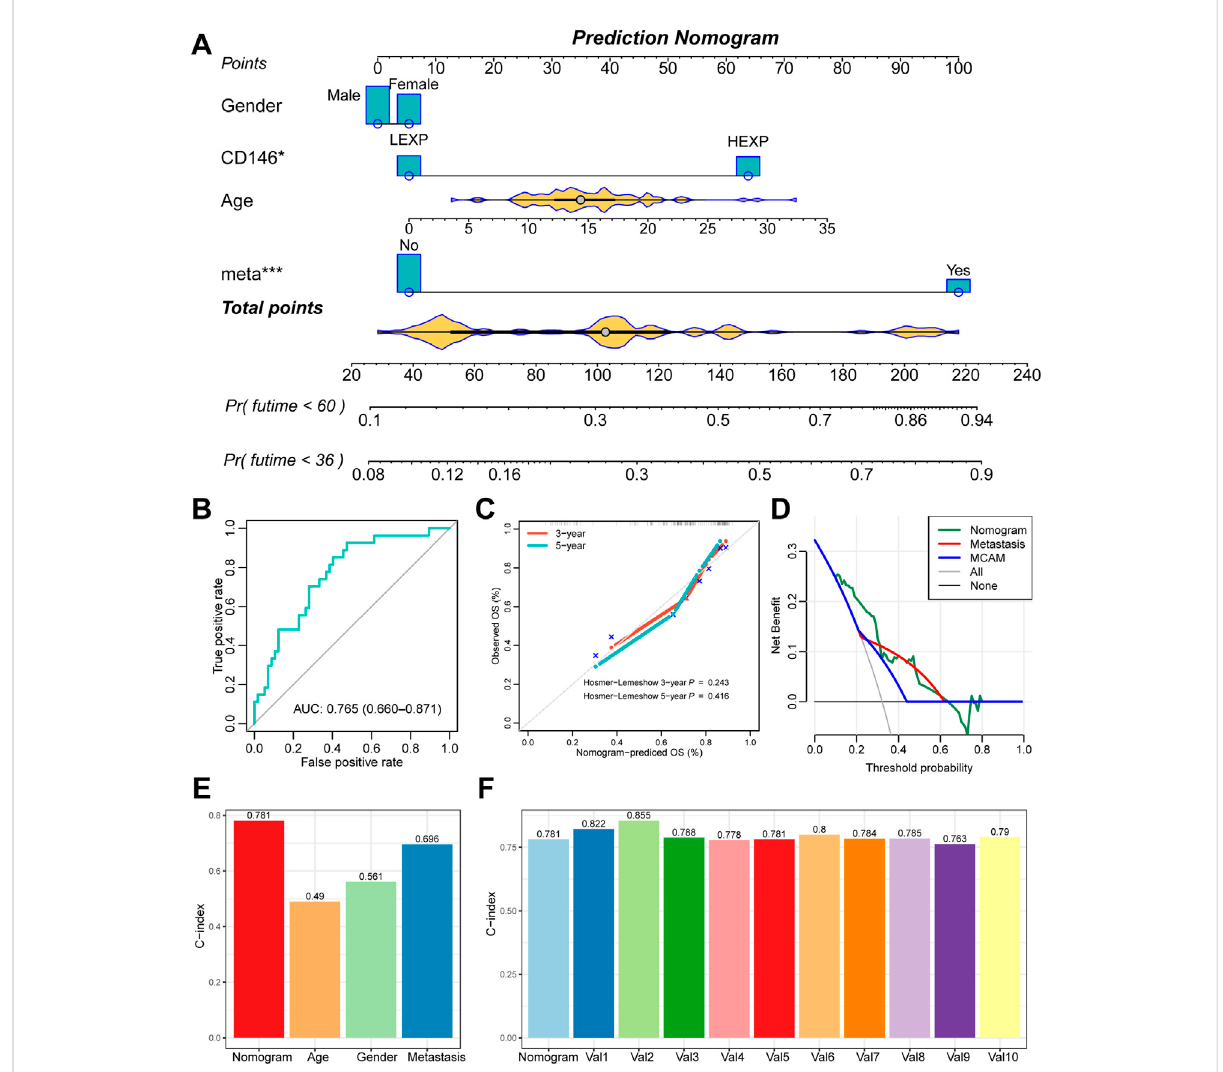
FIGURE 4 Thenomogram furtherenhancedtheprognosticvalueofCD146inOSA. (A) Prognosticnomogramof3-yearand5-year overallsurvivalofOSA patients; (B) ROC curves for the nomogram of overall death events; (C) calibration plot to compare the nomogram prediction and the actual death events; (D) DCA curve for the nomogram, metastasis, and CD146 expression group; (E) C-index of the nomogram, age, gender, and metastasis status; (F) 10-times randomization C-index test to assess the stability of the prognostic